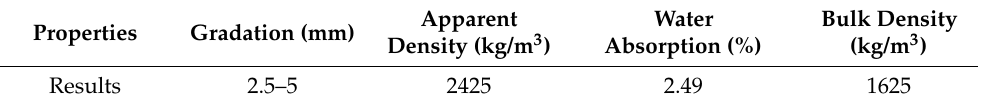
Table 2. Physical properties of M-sand.